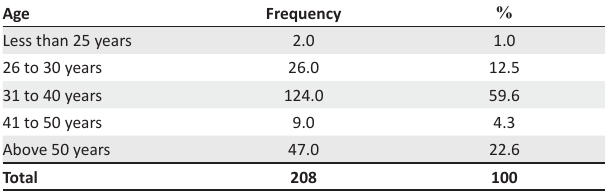
TABLE 6: Characteristic two: Age of respondents.